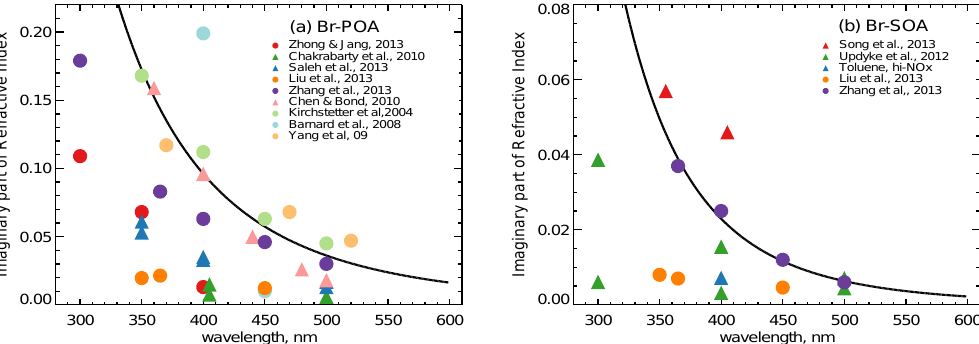
Figure 1. Summary of measured values for the imaginary part of the refractive index, i , for (a) Br-POA and (b) Br-SOA. Estimates from field studies are shown as circles; estimates from laboratory studies are shown as triangles. The black curves are used in our model. See Sect. 2.4 for detailed